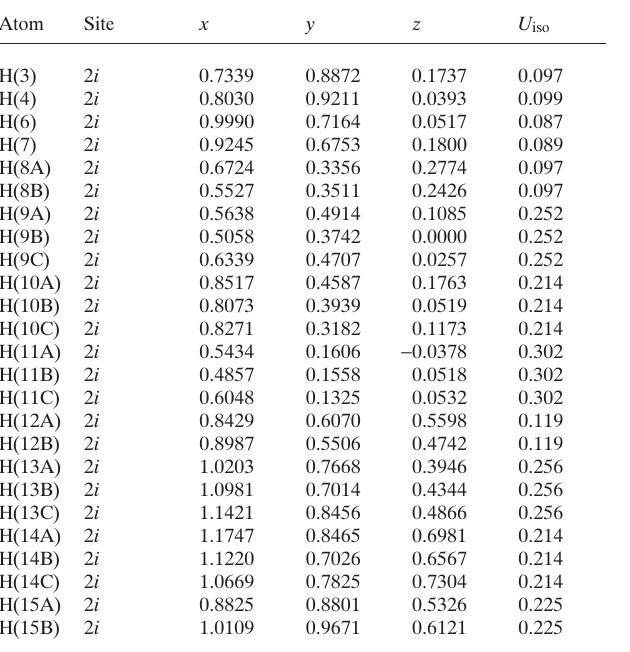
Table 2. Atomic coordinates and displacement parameters (in Å 2 )